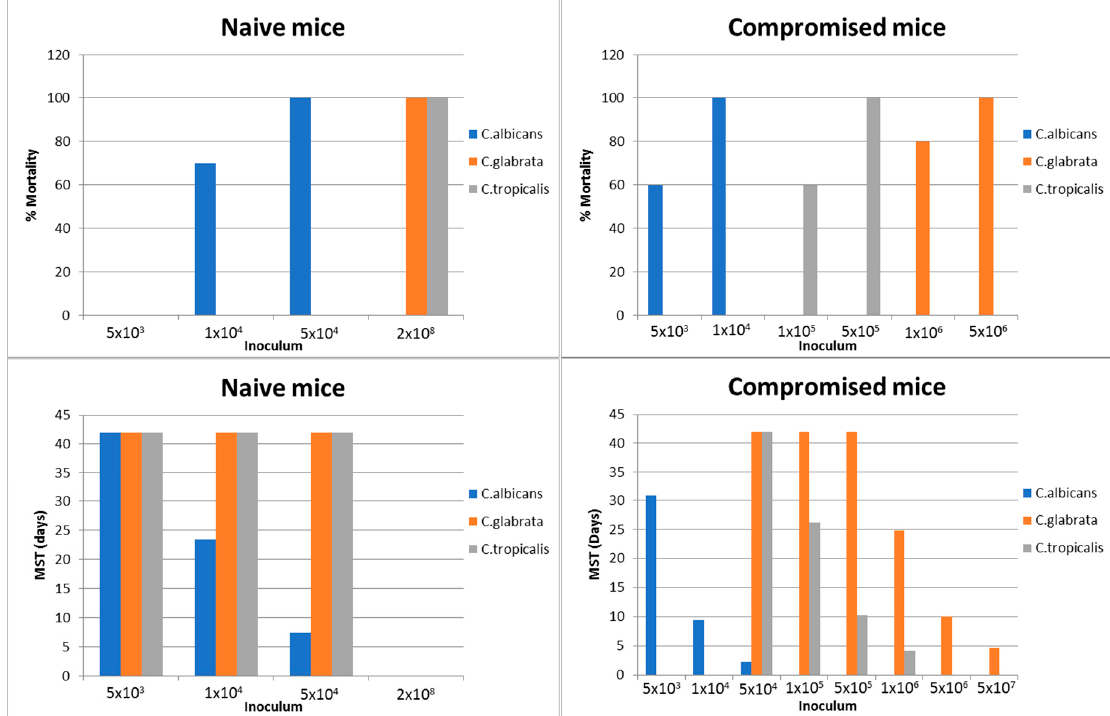
Figure 1. Systemic candidiasis in naïve and compromised ICR mice. Adapted from Schadkchan and Segal [29,30]; Naïve and compromised mice were injected intravenously; Follow-up of 42 days; Data of % survival refer to inoculum which resulted in 100% mortality; MST = Mean survival time.